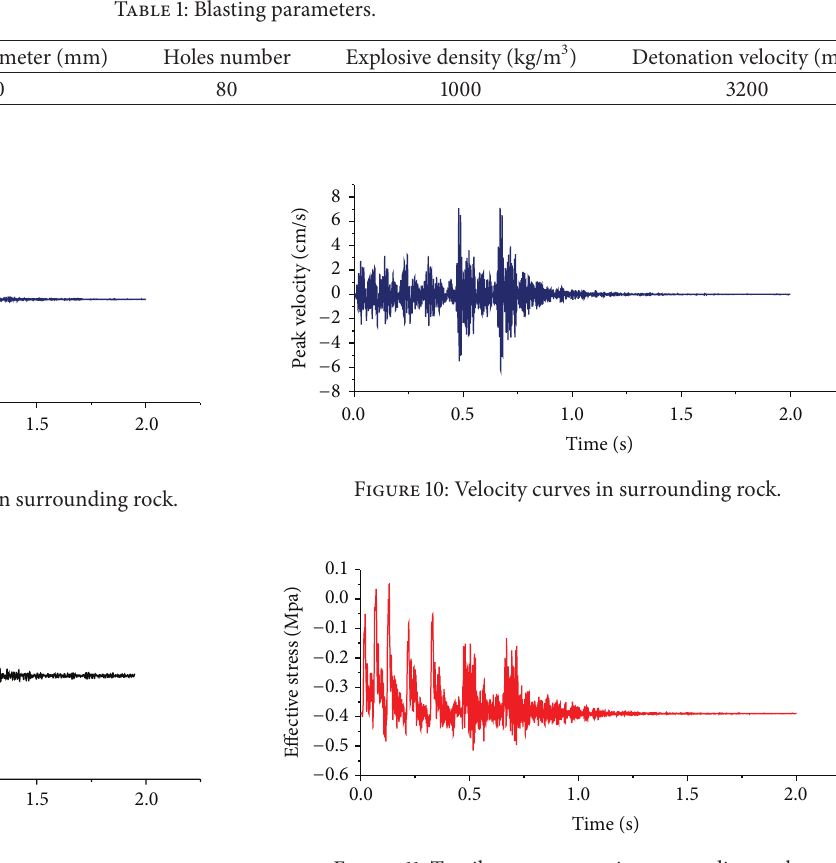
Figure 9: Monitored velocity curves in surrounding rock. Table 2: The time interval of every multistage.